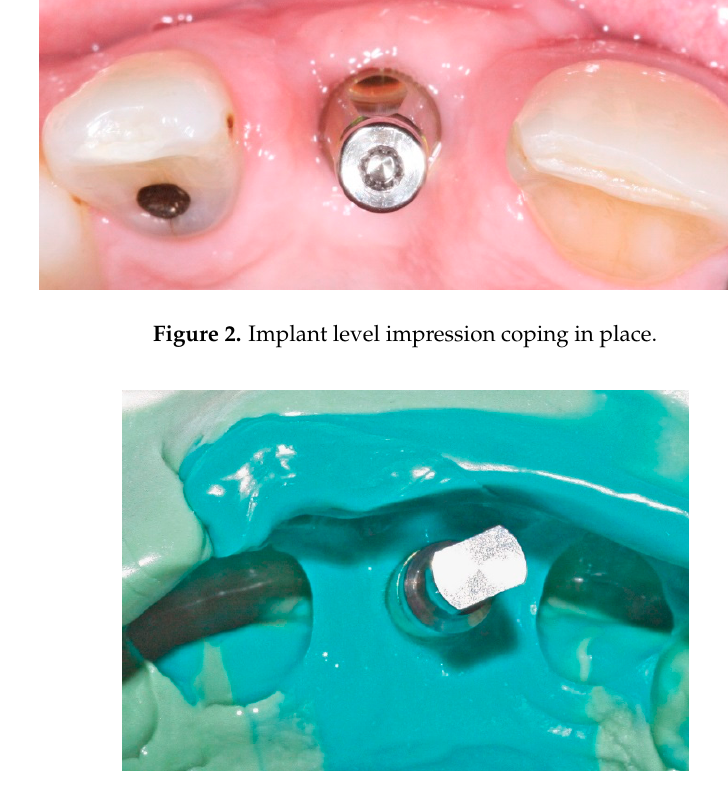
Figure 3. Implant replica connected into impression coping incorporated in PVS (polyvinyl siloxane) closed tray impression technique.